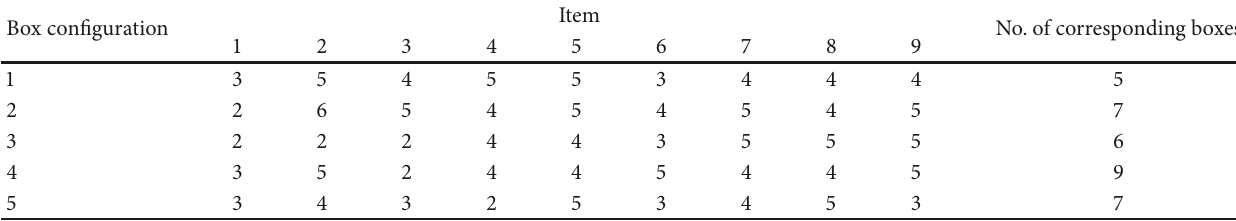
Table 5: Number of each downjacket that can be included in each box configuration and the available number of each box configuration. Box configuration